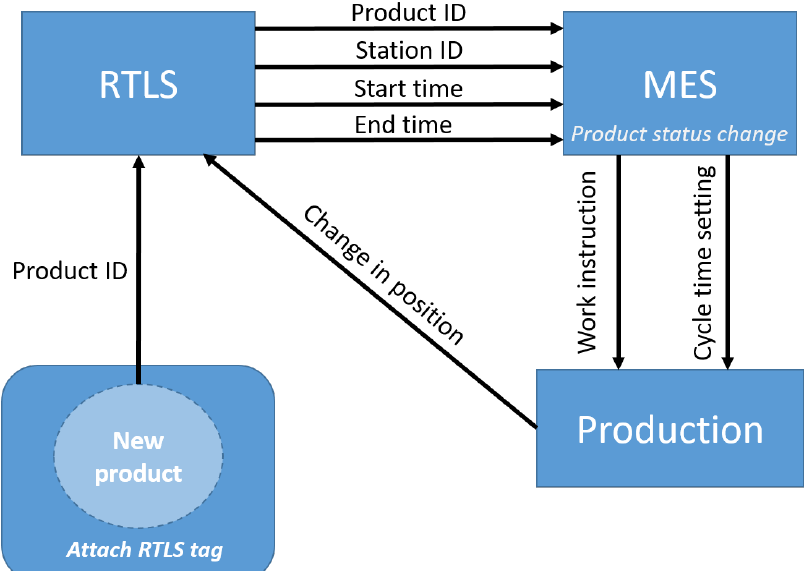
Figure 7. The real-time connection between the Manufacturing Execution System (MES) and production is available based on the